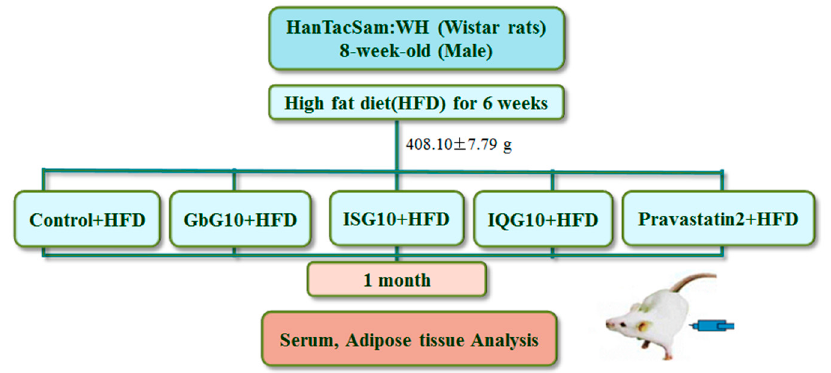
Figure 7. Animal experimental design. GbG: G . bimaculatus glycosaminoglycan; ISG: I .